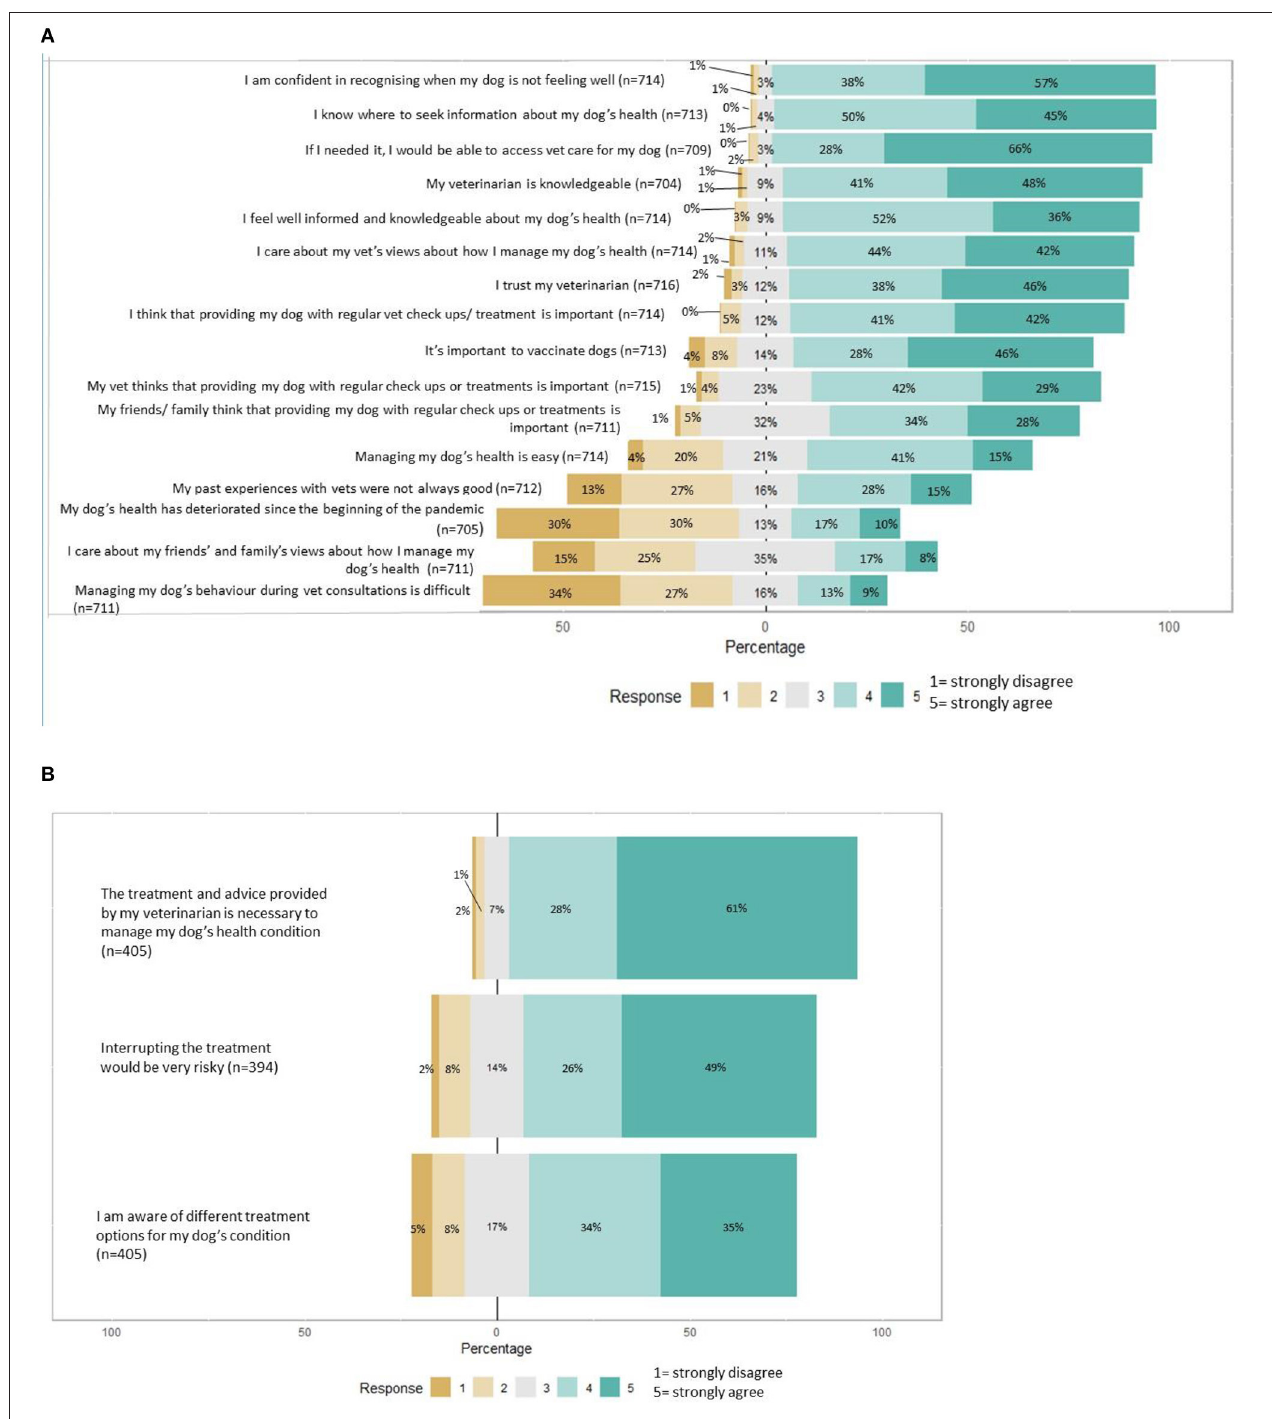
FIGURE 1 | Summary of attitudes to seeking dog healthcare. (A) Summary of dog health-related attitudes among the whole population. (B) Summary of further dog health-related attitudes for owners of dogs with chronic helath issues.